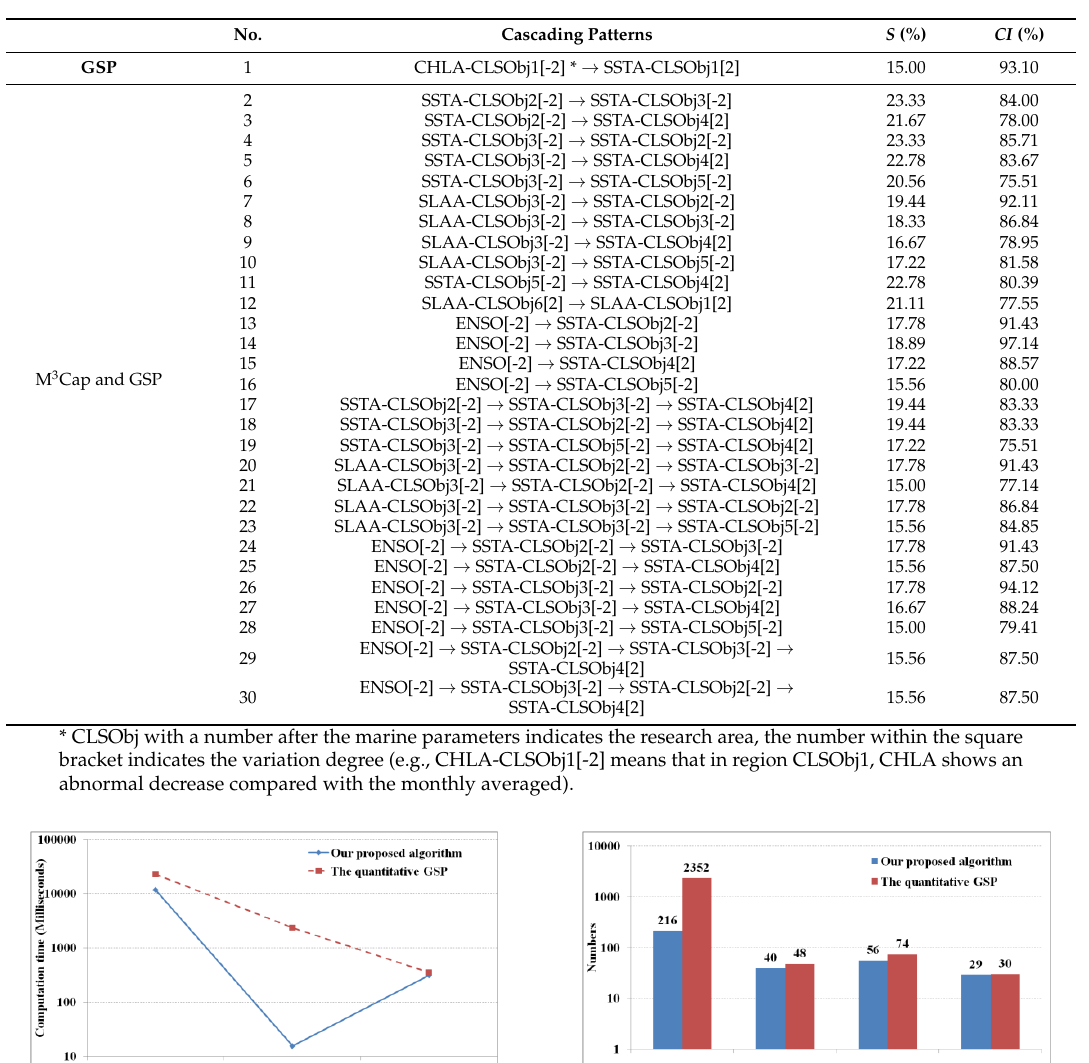
Table 5. Comparisons between M 3 Cap and generalized sequential pattern (GSP) results.